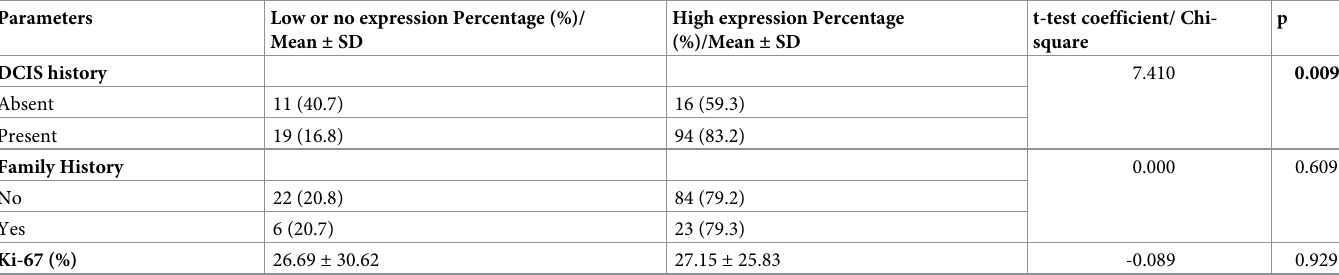
In particular, low SP expression levels were seen in breast cancer tissues of TNBC subtype, TNM stage II and pN0, while high SP expression levels were seen in tissues of pT3 stage (Fig 3). Ki-67 was analyzed as a continuous variable. The expression levels of Ki-67 had no signifi- cant association with age, tumor volume, TNM stage, distant metastasis, presence of lympho- vascular invasion, Her2/neu status, history of DCIS, family history of breast cancer or SP expression levels. However, statistically significant differences were observed between the mean Ki-67 scores and molecular subtype (p = 0.001), grade (p = 0.003), pN stage (p = 0.007), axillary lymph node metastasis (p = 0.001), and ER and PR statuses (p < 0.001); Table 3. As shown in Fig 2b–2d, a Tukey post hoc multiple comparisons test revealed that the mean Ki-67 score was higher in the TNBC subtype (40.1 ± 35.4) compared to the luminal A (20.6 ± 24.9; p = 0.005) and the luminal B subtypes (19.3 ± 14.6; p = 0.002). There were no sta- tistically significant differences between the Her2/neu-enriched subtype and any of the molec- ular subtypes, or between the luminal A and the luminal B subtypes (p > 0.05). Additionally, the mean Ki-67 score in grade III tumors (31.9 ± 29.3) was significantly higher than that in grade II tumors (18.1 ± 18.3; p = 0.008), a near significant difference was found between grade